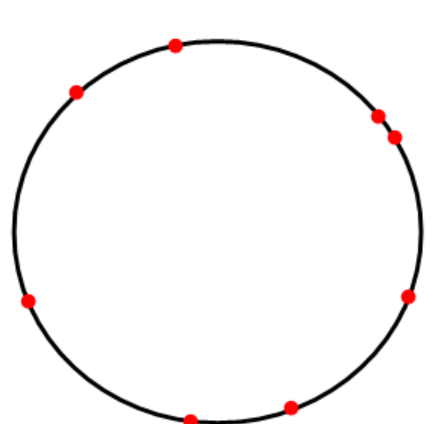
Figure 1. Depiction of a black hole as an ( K + n ) -qubit system. Imagine the region inside the circle is the black hole interior, and the one outside of the circle is the exterior region. The red dots are the scrambled extra n qubits embedded into the horizon. The present figure was inspired by Figure 10 from